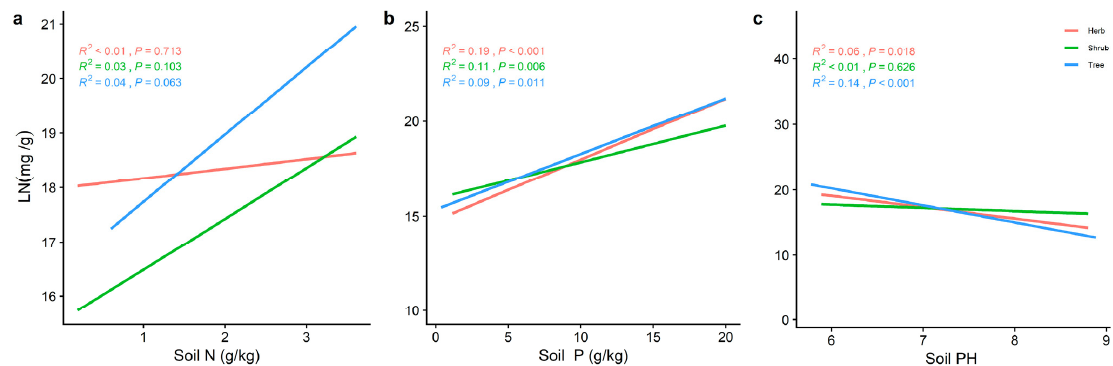
Figure 6. The general linear analysis of soil factors with different life forms of LN. ( a ) General linear relationship between the soil N and LN of plants in the trees, shrubs, and herbs. ( b ) General linear relationship between the soil P and LN of plants in the trees, shrubs, and herbs. ( c ) General linear relationship between the soil pH and LN of plants in the trees, shrubs, and herbs. The red line represents the tree level, the green line is the shrub level, and the blue line is the herb level. R 2 represents how well the model fits the variables studied and P − value represents the level of significance.